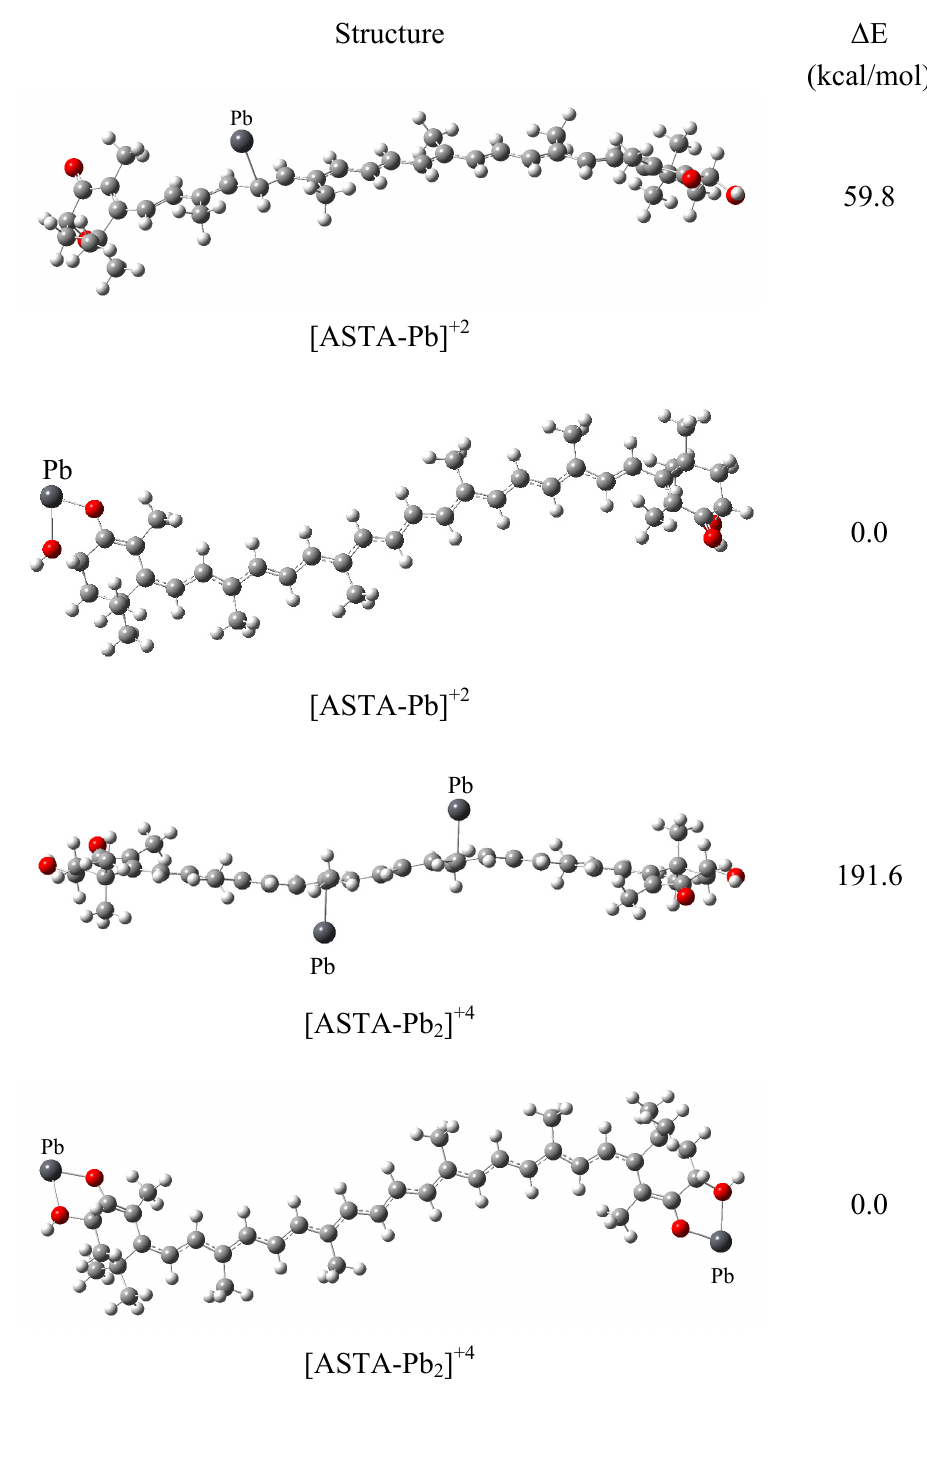
Figure 1. Optimized structures of different isomers of [ASTA-Pb] +2 and [ASTA-Pb is the relative energy with respect to the corresponding most stable